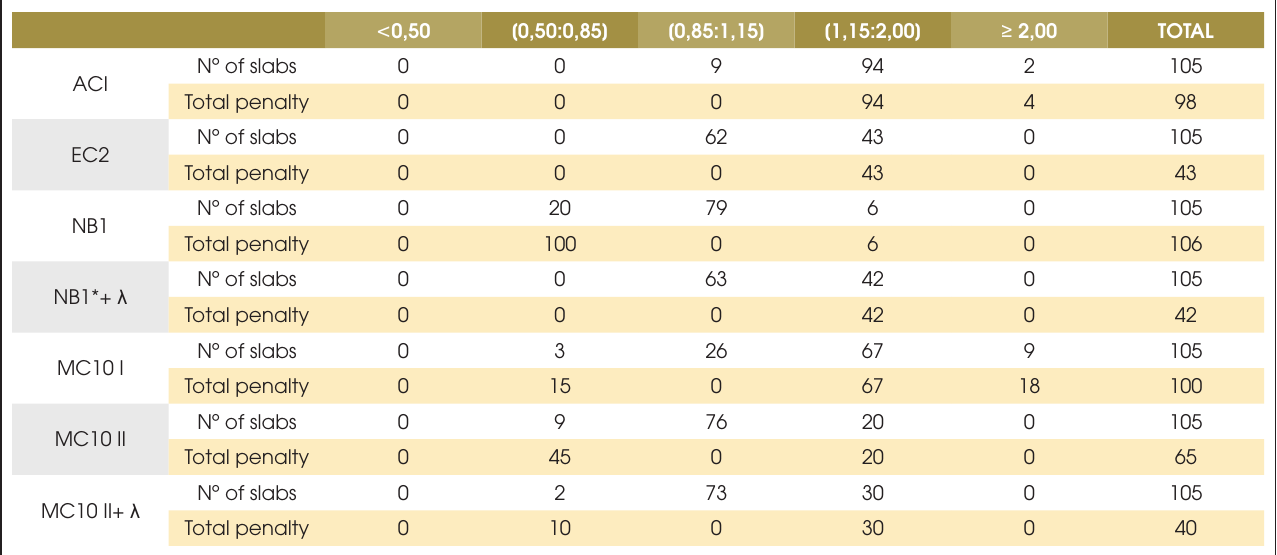
Table 4 – Classification according to the criteria of Collins